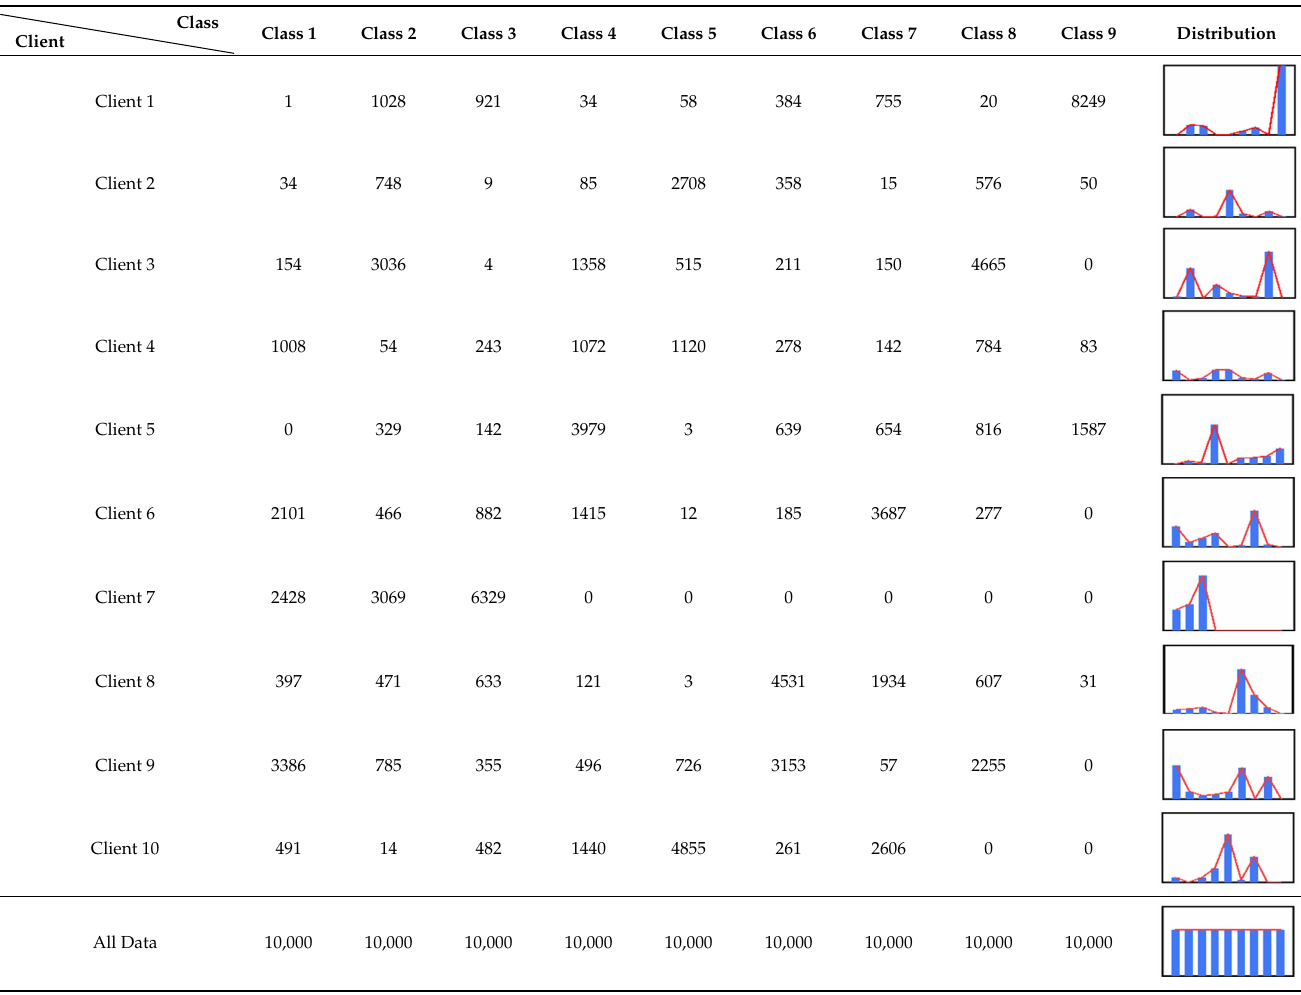
Table 3. The data distribution of the clients after distributing the data using the Dirichlet distribution is shown with the columns indicating the data categories and the horizontal columns indicating the clients. The values in the table represent the data for each category in the different